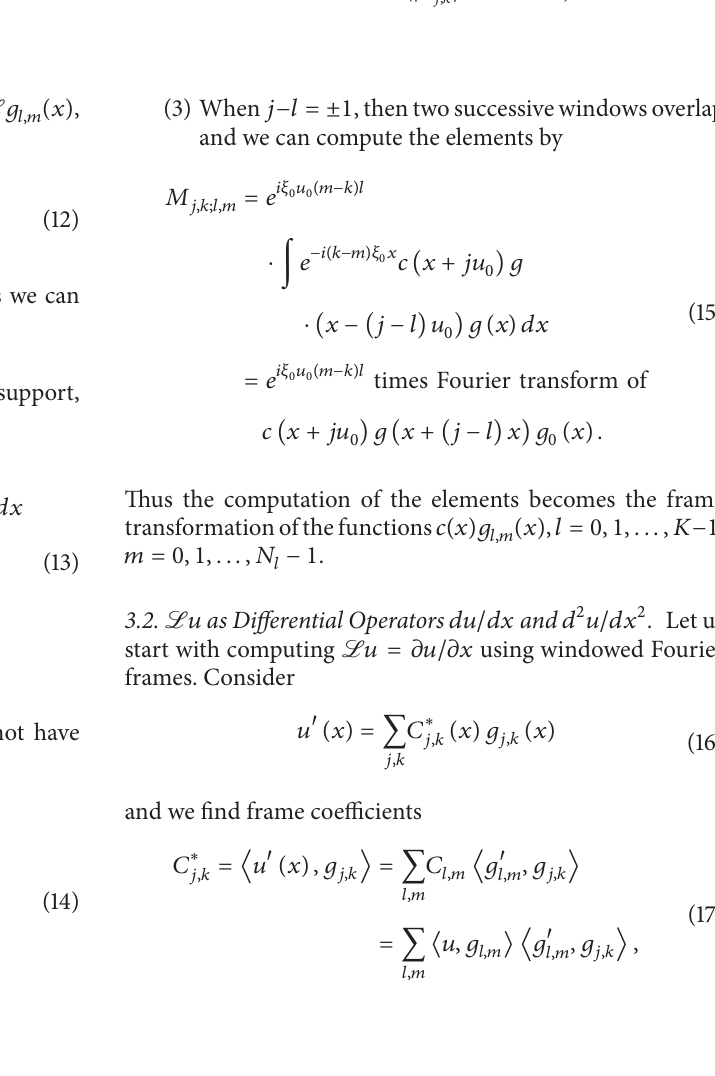
Figure 3: This figure shows the original function 𝑓 and recovered function from the frame coefficients ( |𝐶 𝑗,𝑘 | > 𝛿 = 10 −4 ) and the error we made with such an